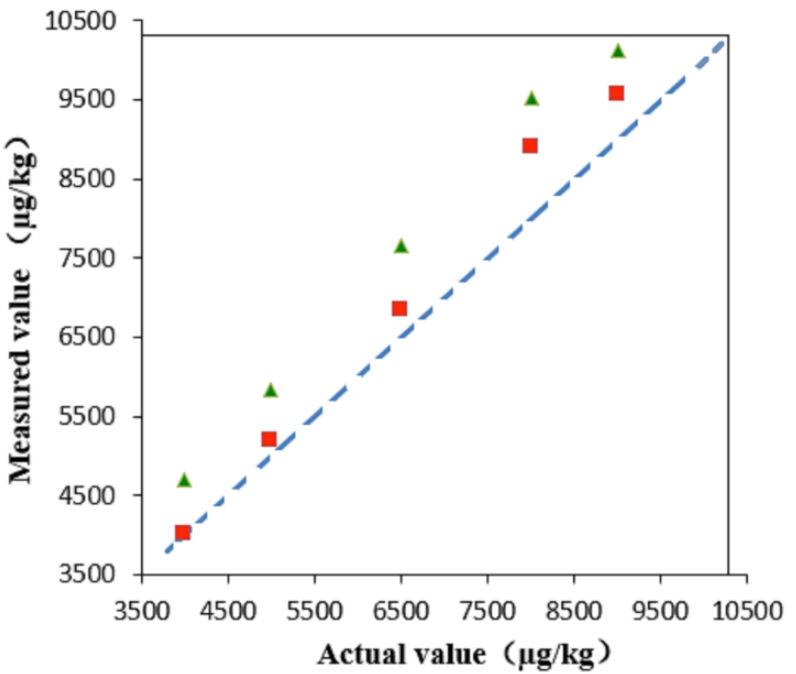
Figure 2. Comparison of quantitative results of sinapine by molecular ion (green triangles) and isotopic ion (red squares).